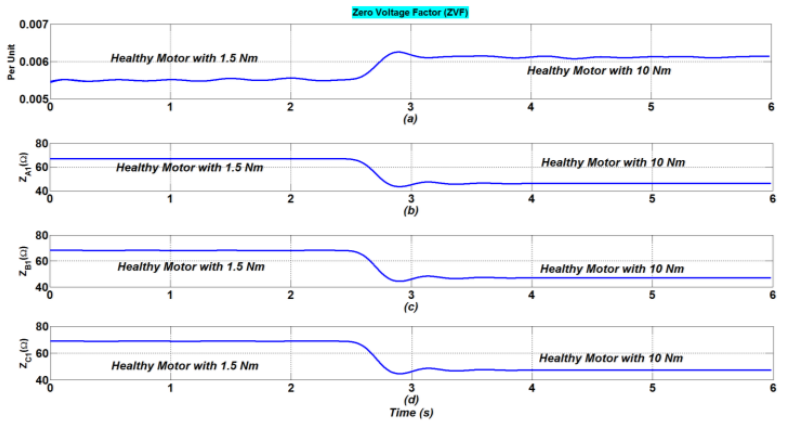
Figure 11. ZVF indicator and estimated impedances, assessed for healthy state and in the presence of load transient conditions. ( a ) ZVF; ( b ) Z A1 ; ( c ) Z B1 ; ( d ) Z C1 .